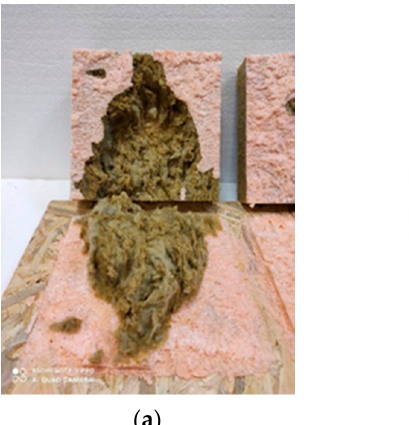
Figure 9. Illustration of the model of damage of 8 mm thick bonds ( a ) CPB/23/50/8 series sample— C/MW damage, ( b ) OSB/23/50/8 series sample—C/MW damage combined with C/PU damage and ( c ) CPB/23/50/8 series sample—C/MW damage (C/MW—cohesive within the MW, C/PU— cohesive within the PU adhesive).